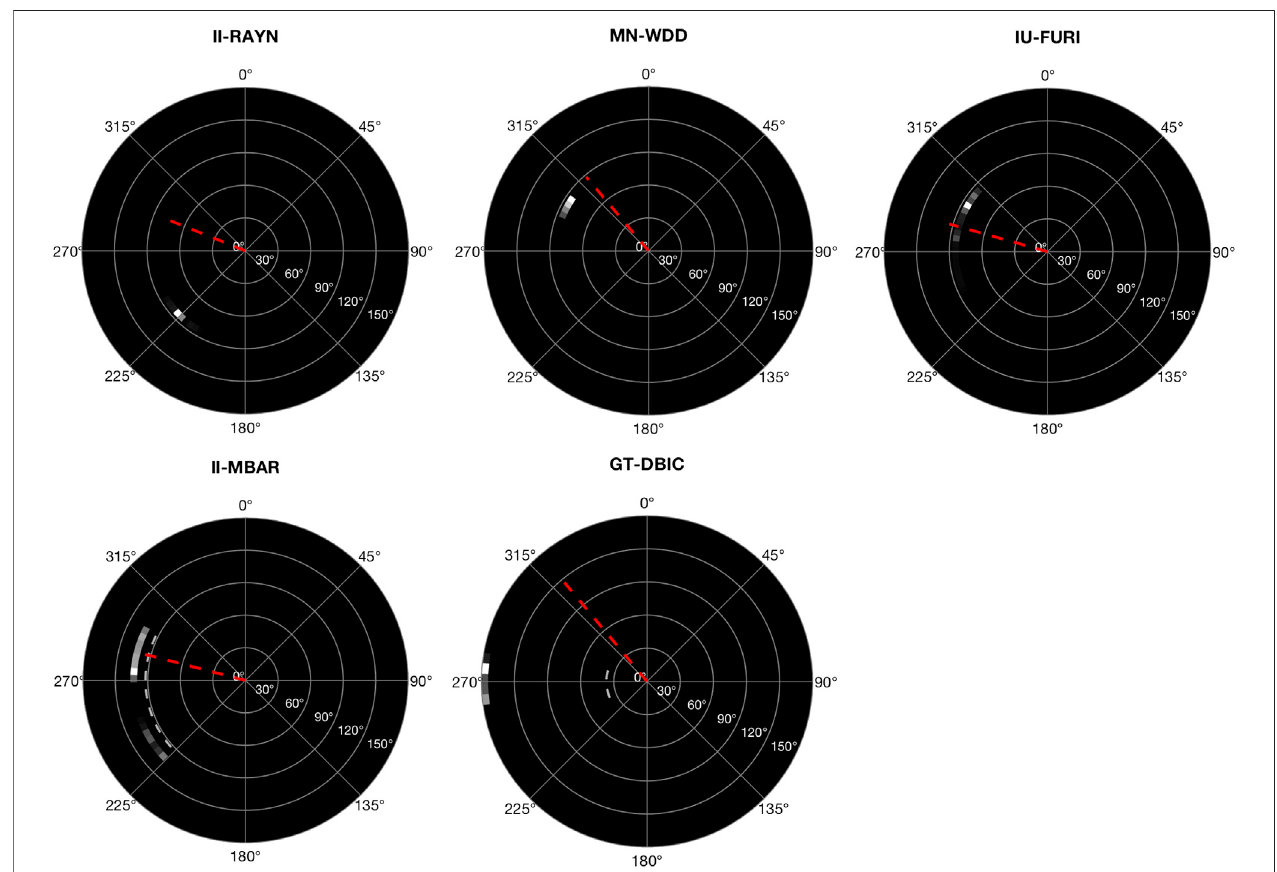
FIGURE 5 | Single-station location of Hokkaido, Japan, in the event reference frame (compare with station-event geometry in Figure 1B ). All stations identify the correct epicentral distance and azimuth range (except for DBIC and RAYN with an azimuth bias of − 50 ° ).